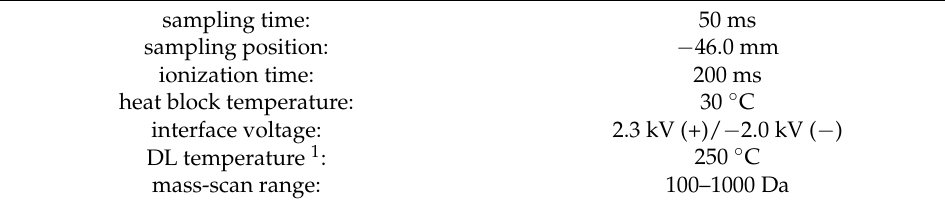
Table 1. The measurement conditions.